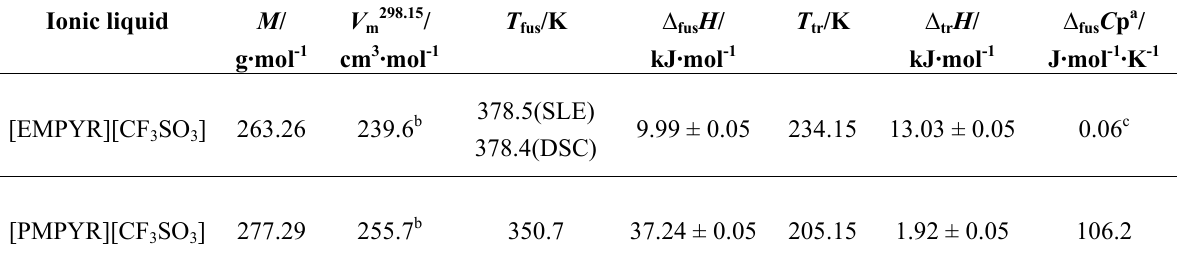
Table 2. Thermophysical constants of pure ILs (DSC